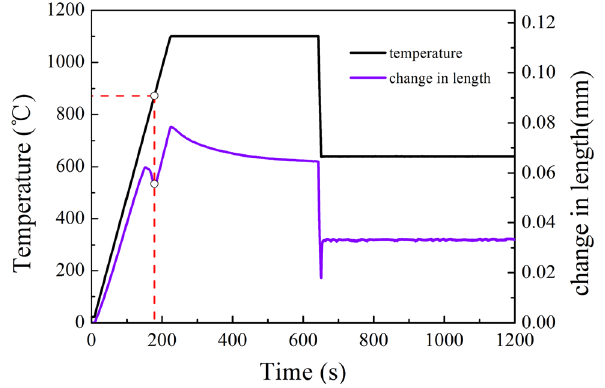
Figure 4: Processing route for CHT with decreasing quenching